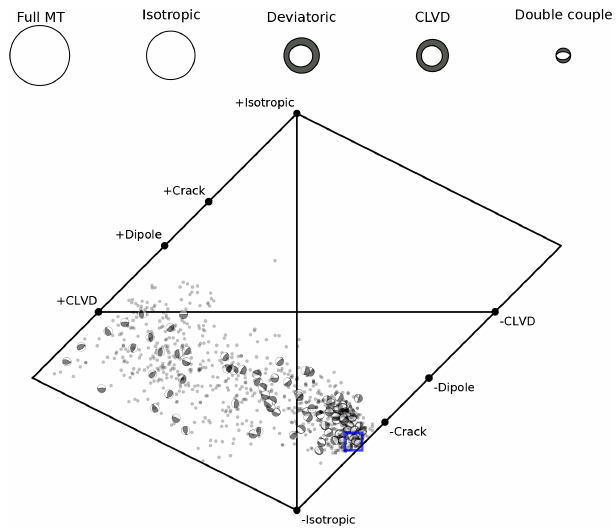
Figure 8. Same as Fig. 6 but for the aftershock around 8min after the underground test.